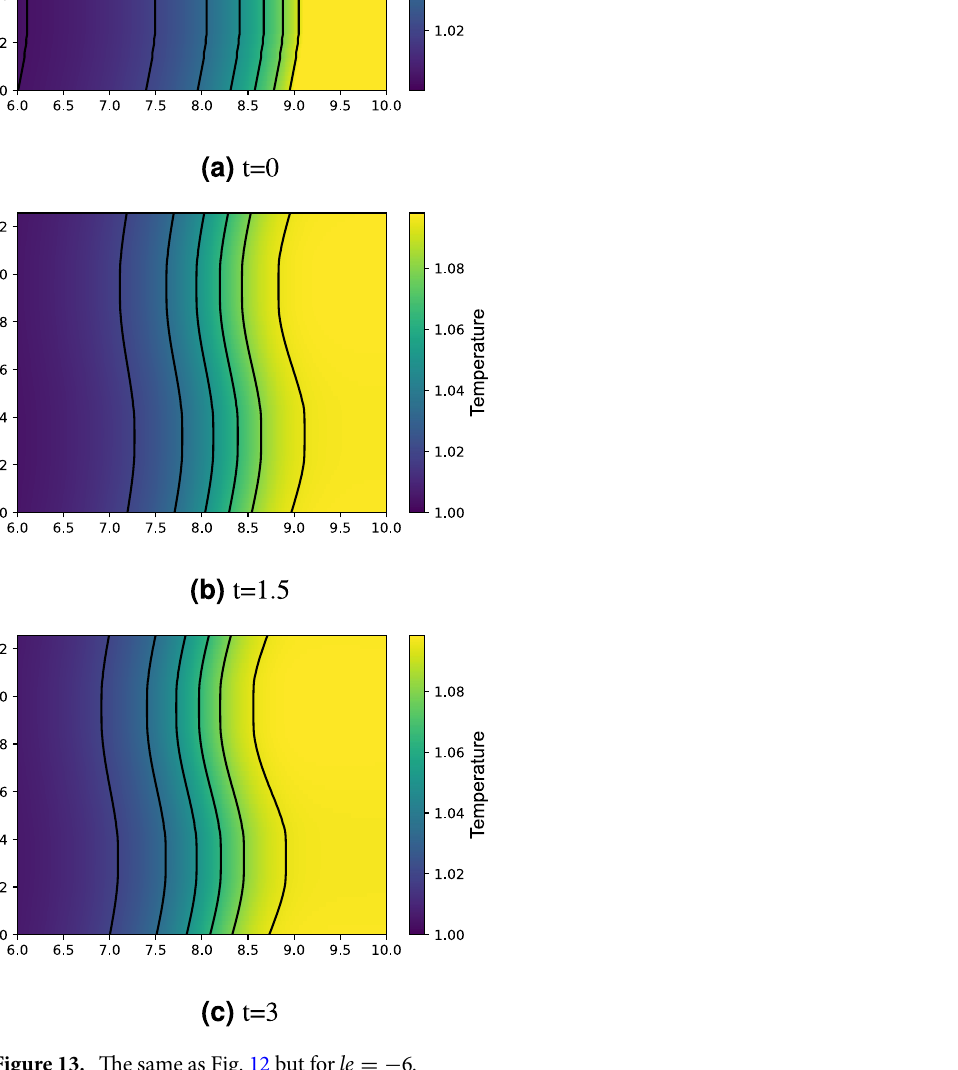
Figure 13. The same as Fig. 12 but for le